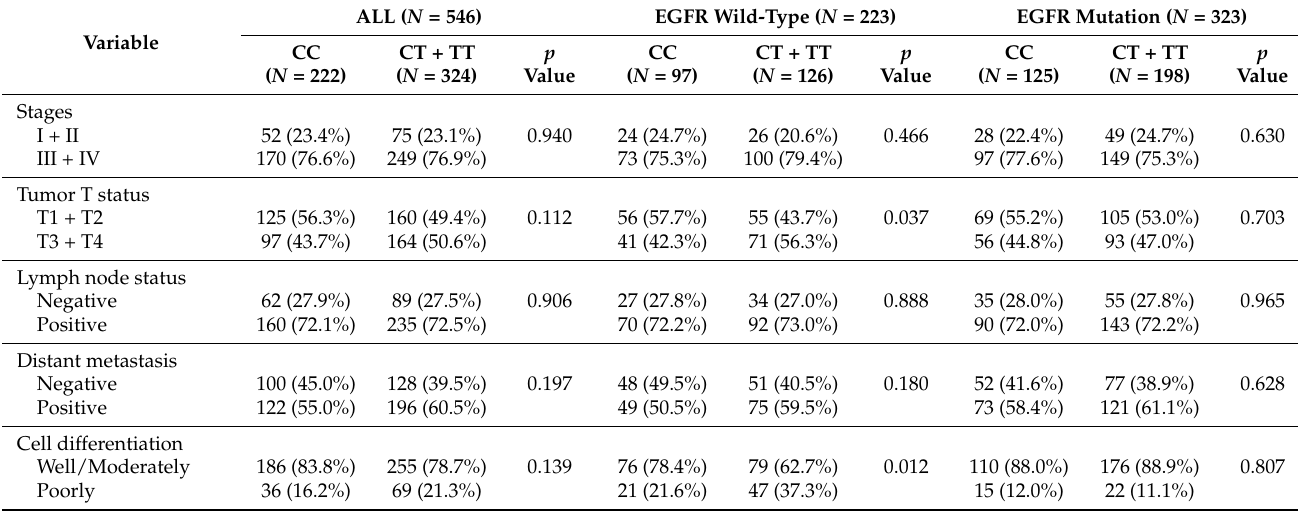
Table 4. Clinicopathologic characteristics of lung adenocarcinoma patients with EGFR mutation, stratified by polymorphic genotypes of H19